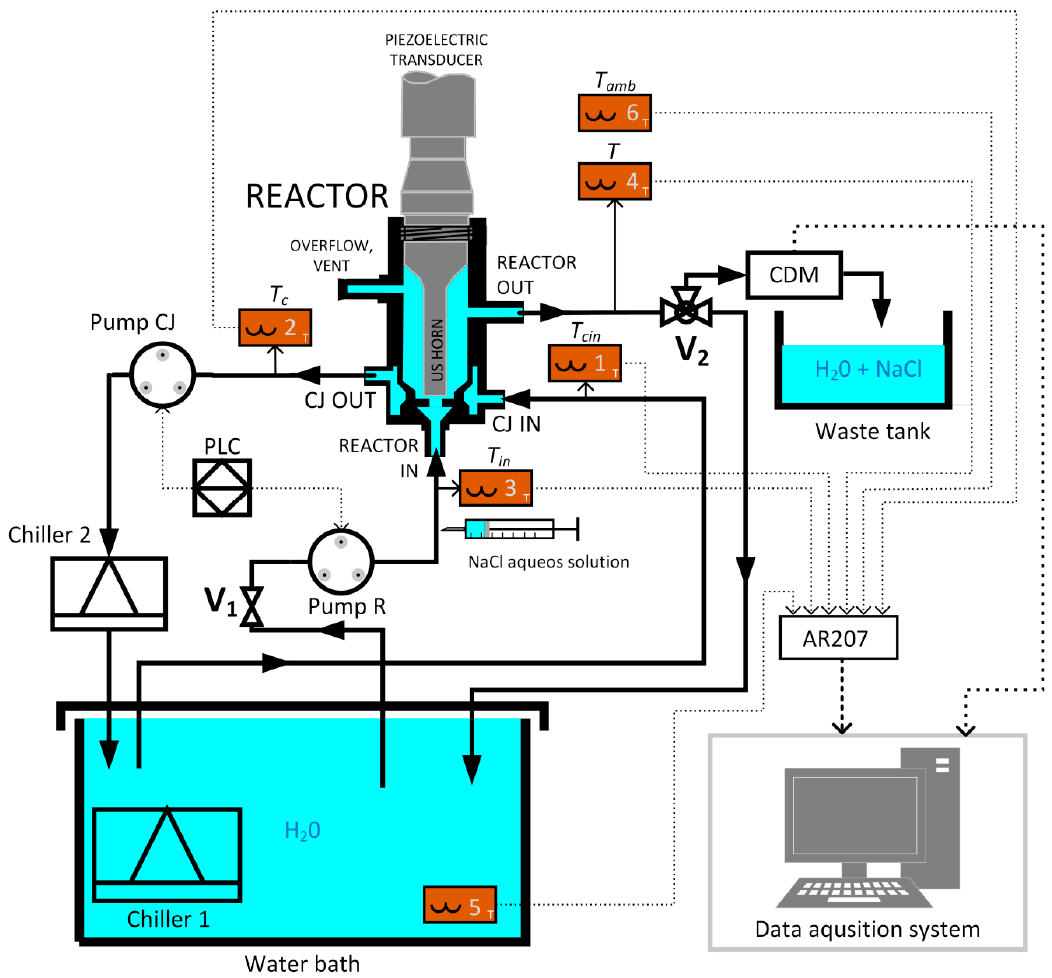
Figure 1. Scheme of the measuring setup for ultrasonic tests. 88